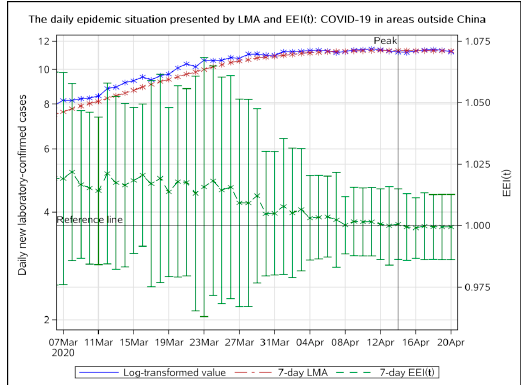
Figure 4. The daily epidemic situation presented by LMA and EEI(t), COVID-19 in areas outside China, from 7 March to 20 April 2020. The blue line indicates the change of the log-transformed value over date. The brown line indicates the change of 7-day LMA over date. The green line indicates the change of the EEI(t) over date. LMA, moving average of log-transformed daily new cases and EEI(t), epidemic evaluation index (t).